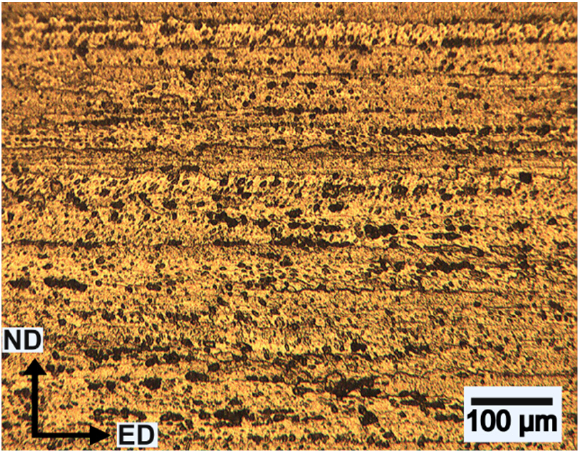
Figure 15. Optical micrographs image of the Al billet after the ECAE deformation (×100).